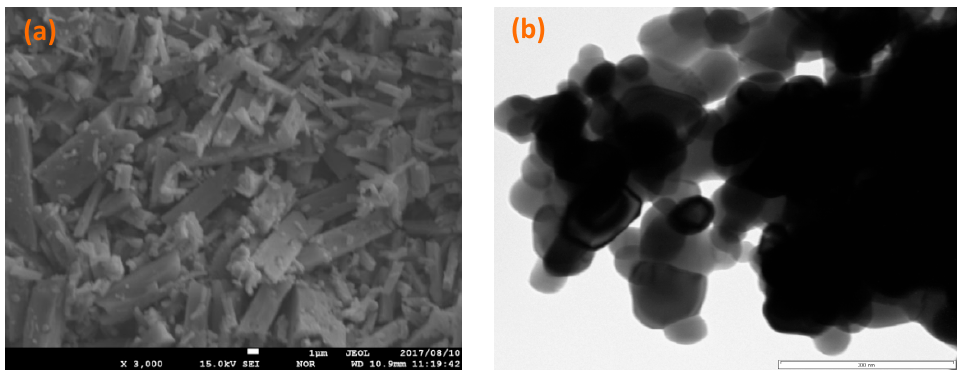
Figure 4. ( a ) SEM and ( b ) TEM images of Ag/ZnO nanocomposite.